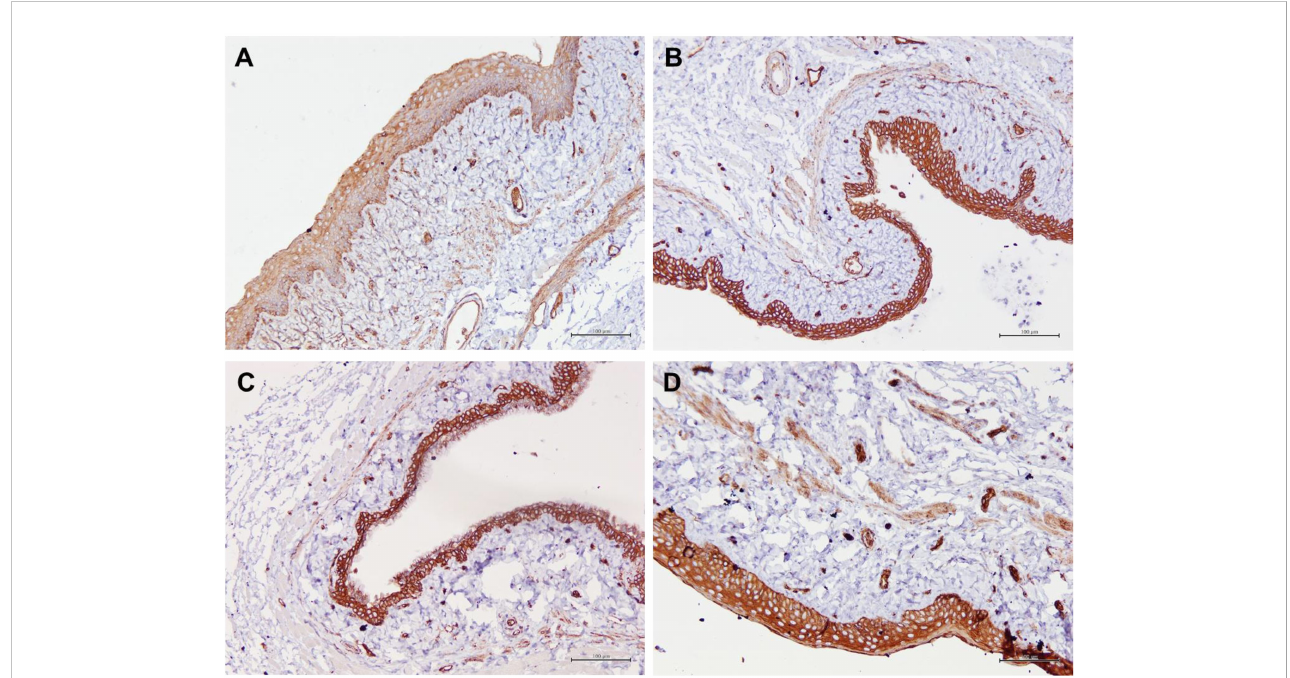
FIGURE 4 Structure of the rat vaginal epithelium and Aqp1 protein localization in the rat vaginal tissue following a two-week administration of Gelam honey at 0.2 g Gelam honey/kg bw/day doses. (A) Gelam honey and bilateral oophorectomized group (Gelam honey+Ovx), (B) Estrogen replacement therapy and bilateral oophorectomized group (ERT+Ovx), (C) Bilateral oophorectomized group (Ovx) and (D) Sham group (SC). The tissues were stained with DAB/ HRP stain for protein localization (in brown) and counterstained with H&E for nuclear staining. All measurement bars are equivalent to 100 µm.